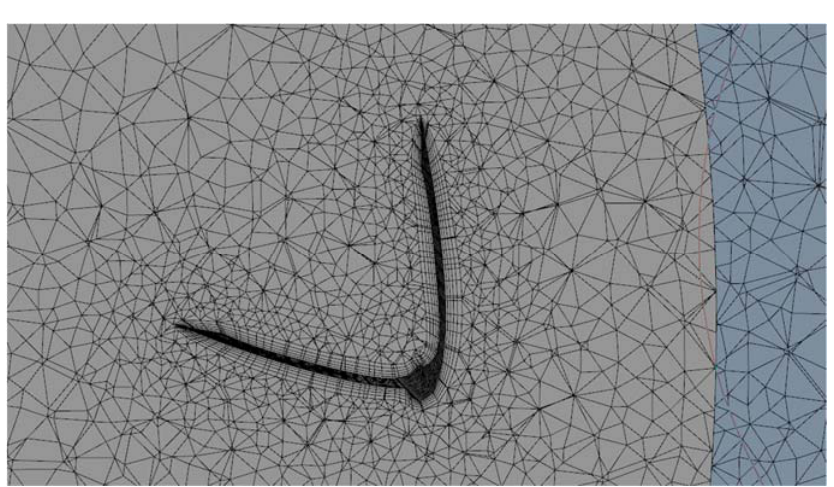
Figure 4. Boundary layer settings.